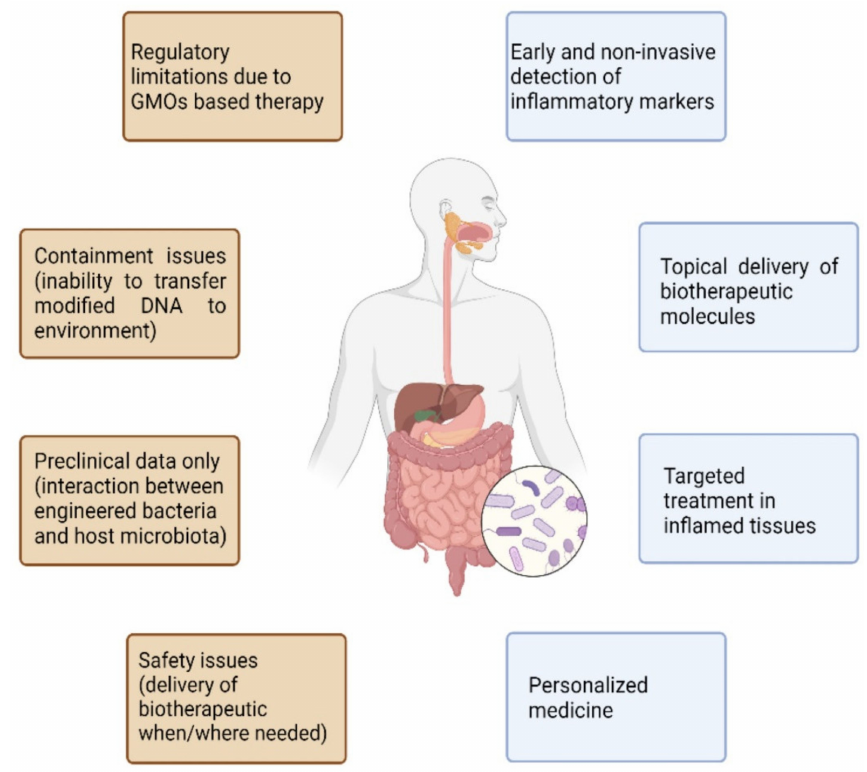
Figure 3. Current advances and concerns in developing live